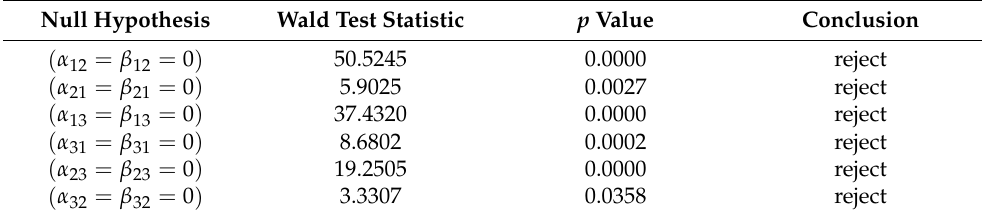
Table 10. Wald test of fluctuation spillover effect in the first stage.